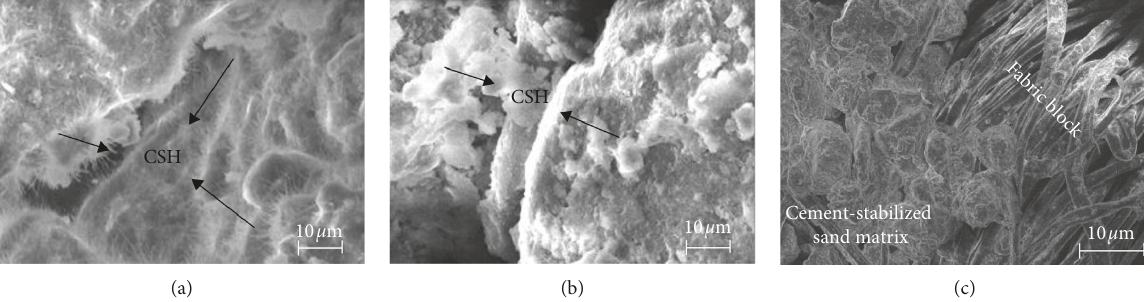
Figure 13: Cement hydration process and integration of fabric blocks with the cement-stabilized sand matrix: (a) curing for 3 days; (b) curing for 14 days; (c) mesomorphology after integration of fabric blocks with the cement-stabilized sand